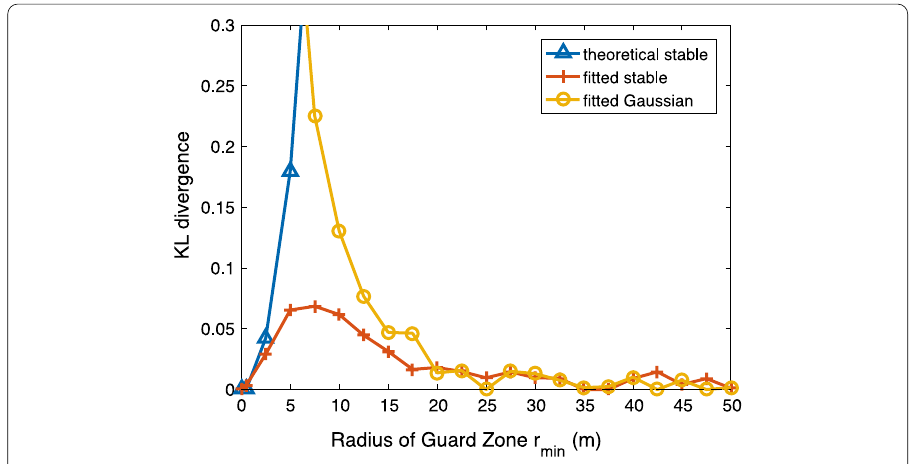
Fig. 3 Plot of the KL divergence between the simulated data set from HPPP and three statistical models (under different guard‑zone radii): theoretical stable model ( α = 4 /η ); fitted stable model ( ˆ α) ; and fitted Gaussian